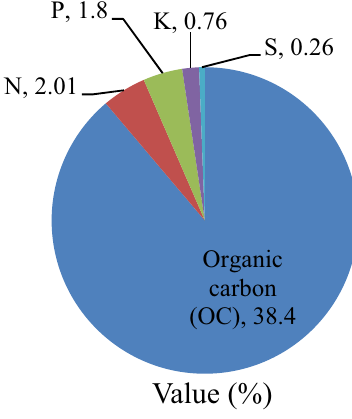
Figure 5. Chemical composition of pressmud (PM)